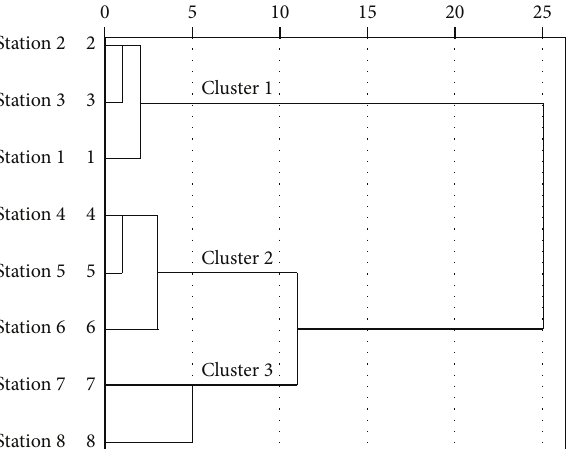
Figure 3: Dendrogram of cluster analysis of the water quality